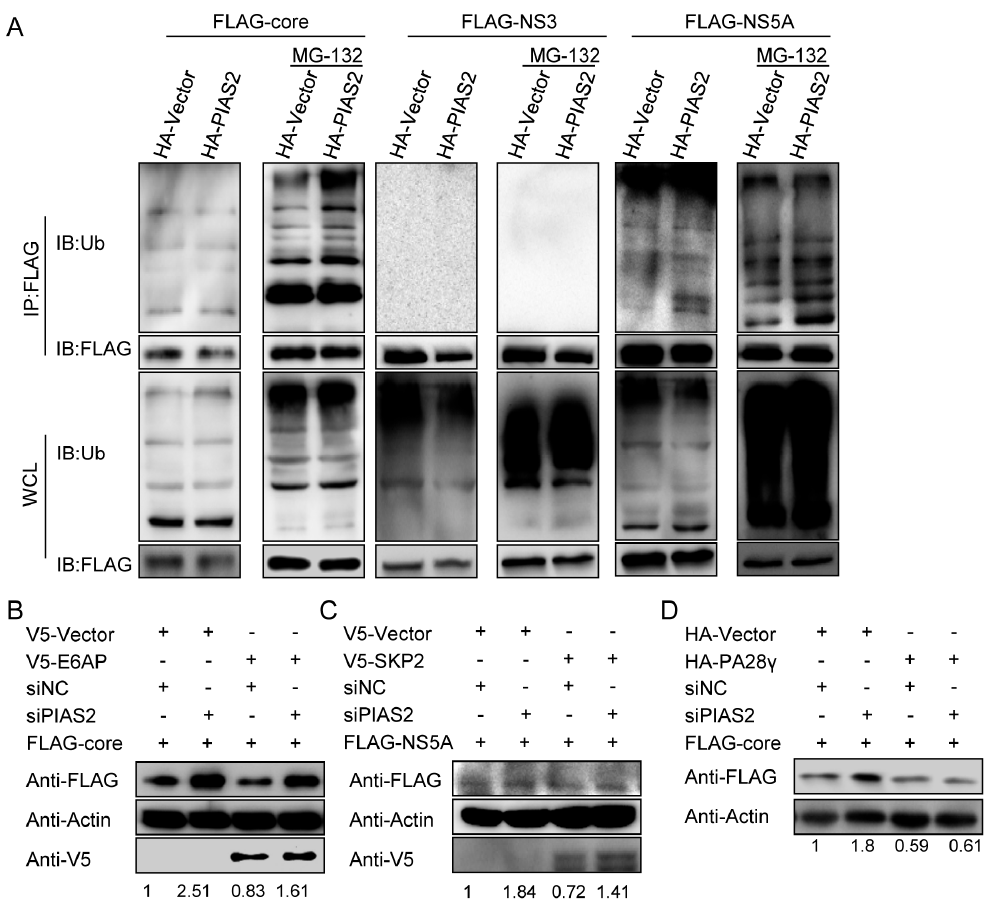
Figure 6. The influence of PIAS2 on HCV protein ubiquitination. ( A ) 293T cells were transfected with the indicated plasmids together with Ub and Cer-SUMO1 expression plasmids. MG132 treatment was performed 4 h before the total protein was extracted. Then, immunoprecipitation and western blotting were performed; ( B – D ) 293T cells were transfected with the siRNA and plasmids as indicated. Total protein was collected and detected by western blotting, WCL: whole cell lysate.